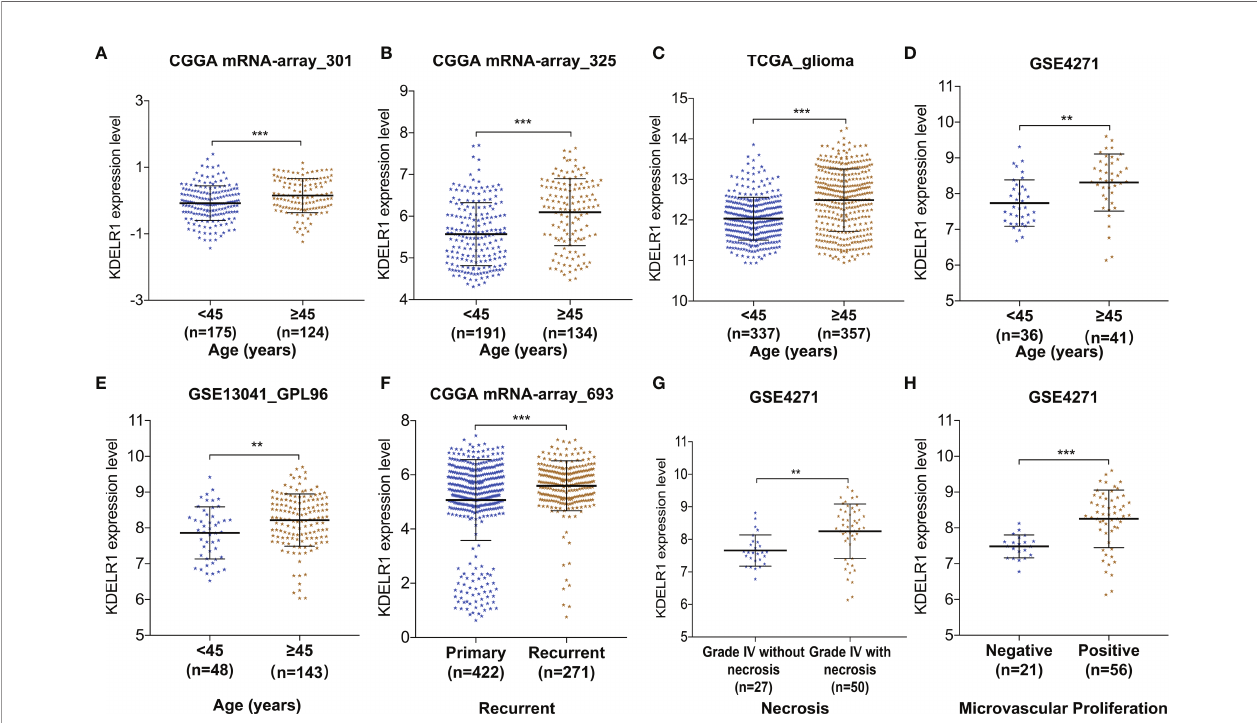
FIGURE 3 | The relationships between KDELR1 expression and clinical features in glioma samples from different databases. (A – E) KDELR1 expression is signi fi cantly associated with age in mRNA-array_301 and mRNA-array_325 of CGGA, TCGA_glioma, GSE4271, and GSE13041 (GPL96), respectively. (F) The recurrent gliomas had a higher expression level of KDLER1 in CGGA mRNA-array_693. (G) The expression of KDLER1 is highly upregulated in grade IV gliomas with necrosis than ones without necrosis in the dataset GSE4271. (H) Gliomas with microvascular proliferation had a higher expression level of KDLER1 than gliomas without microvascular proliferation in GSE4271. **,P < 0.01; ***,P <